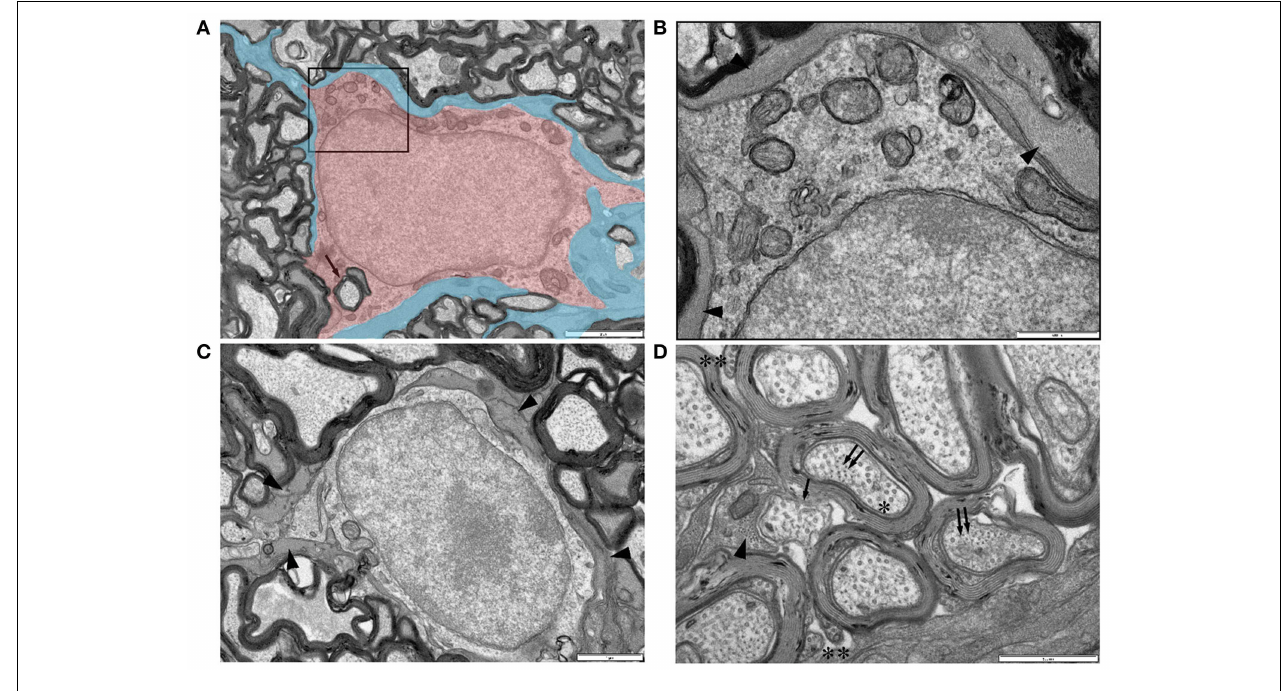
FIGURE 8 | Ultrastructural features of glia in adult RON. (A,B) An oligodendrocyte (shaded red), identified on the basis that it completely encircles a myelinated axon in which the outer membrane is contiguous with the cell (arrow) (boxed area in “ A ” is shown at higher gain in “ B ”). Note the relatively uniform chromatin throughout the large nucleus and the numerous mitochondria in the soma. The cell is completely ensheathed by astrocyte processes, identified by the presence of glial filaments ( A : shaded blue; B : arrow heads). (C) A further example of an